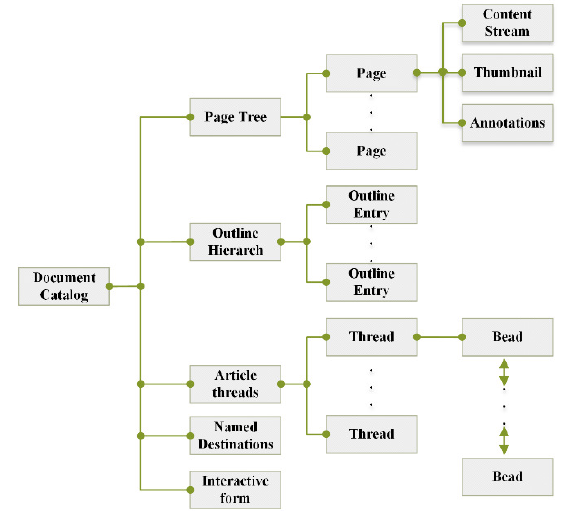
Fig. 6: The Structure of PDF